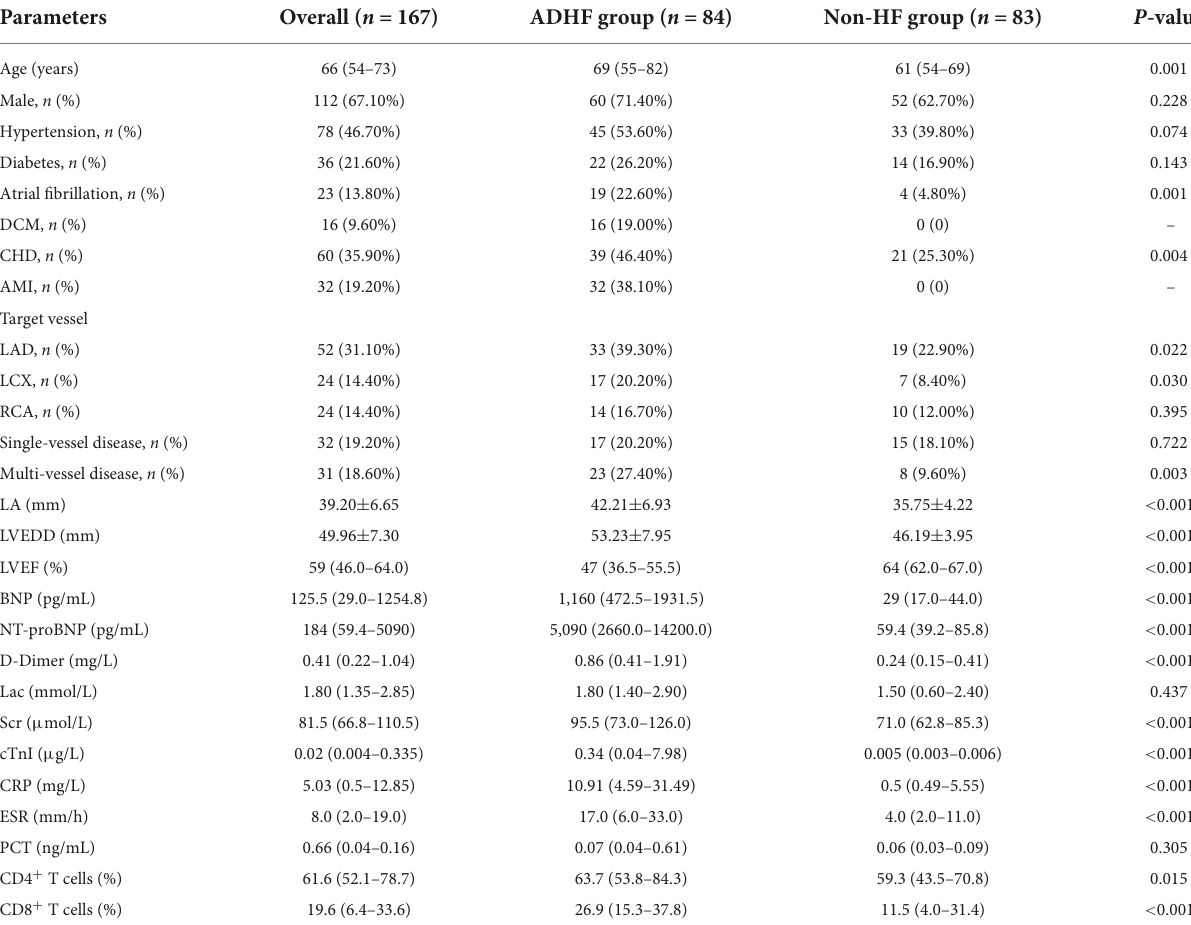
TABLE 1 Clinical characteristics of